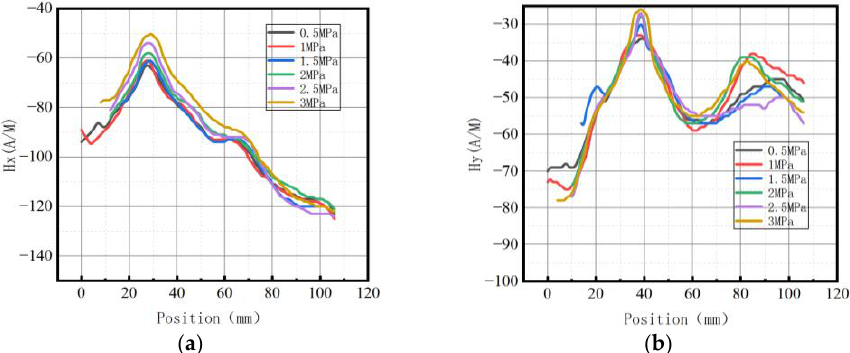
Figure 34. Variations of S ( K ) at weld crack under different internal pressures. ( a ) Axial component of S ( k ); ( b ) radial component of S ( k ).